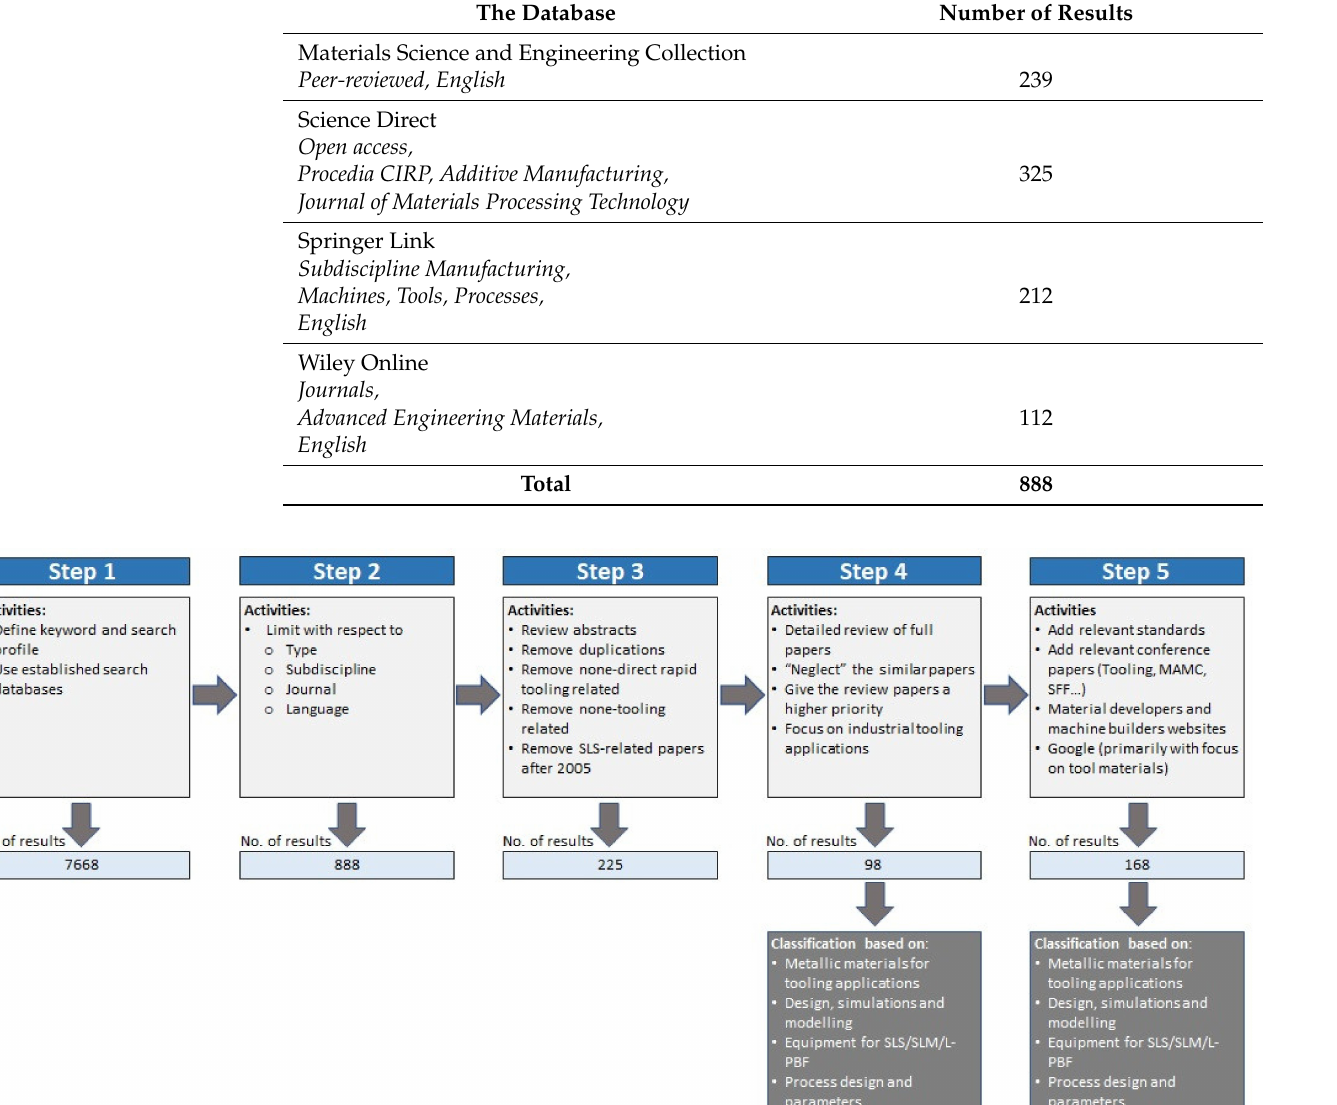
Table A2. The selection criteria per database and the number of results. The indicated selection criteria were applied to the results obtained in the first step, i.e., Table A1.